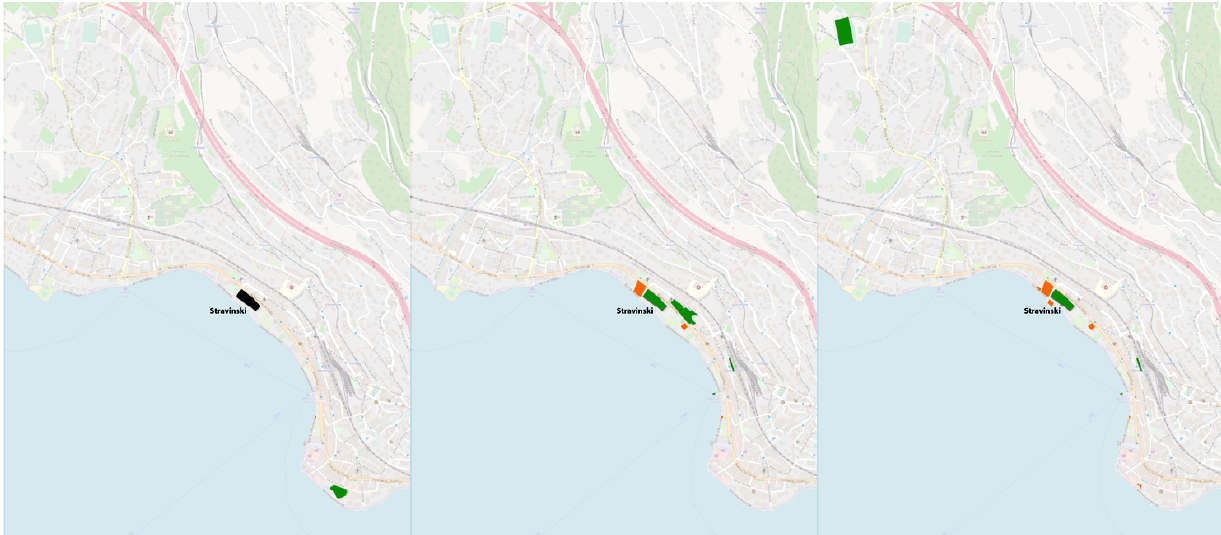
Figure 6. Analysis of the evolution of Festival sites and their access (in green: stages with paid access; in orange: freely accessible stages―openness). Note: From left to right: 1990, 2000, and 2019.